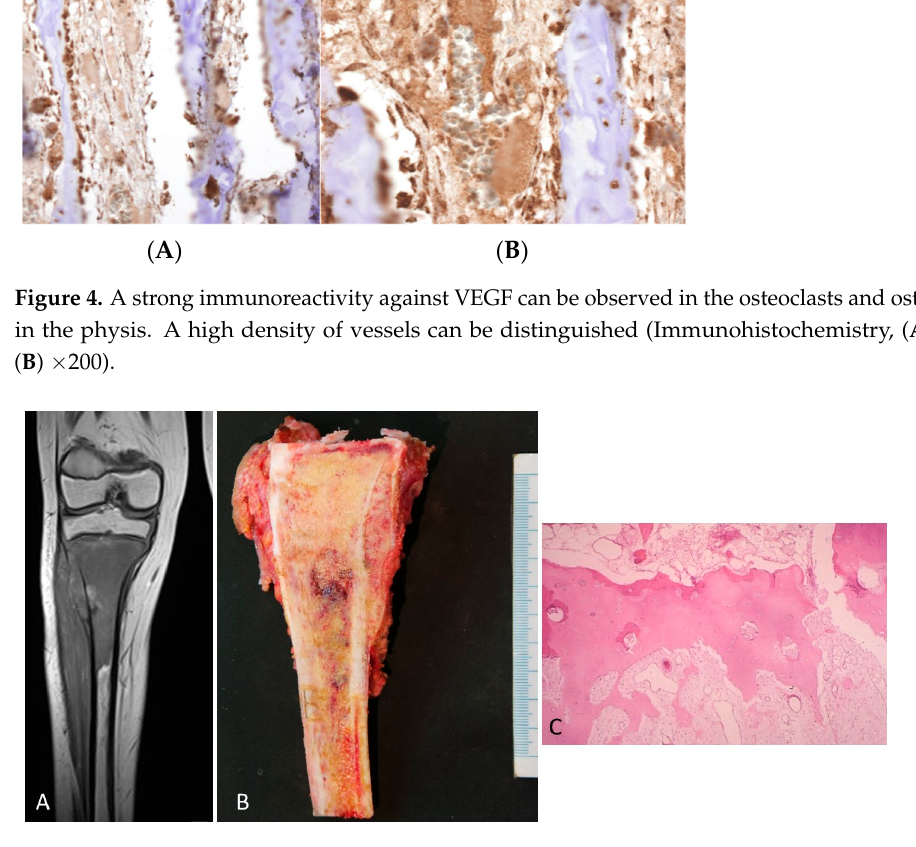
Figure 4. A strong immunoreactivity against VEGF can be observed in the osteoclasts and osteo- blasts in the physis. A high density of vessels can be distinguished (Immunohistochemistry, ( A ) ×100, ( B ) ×200).